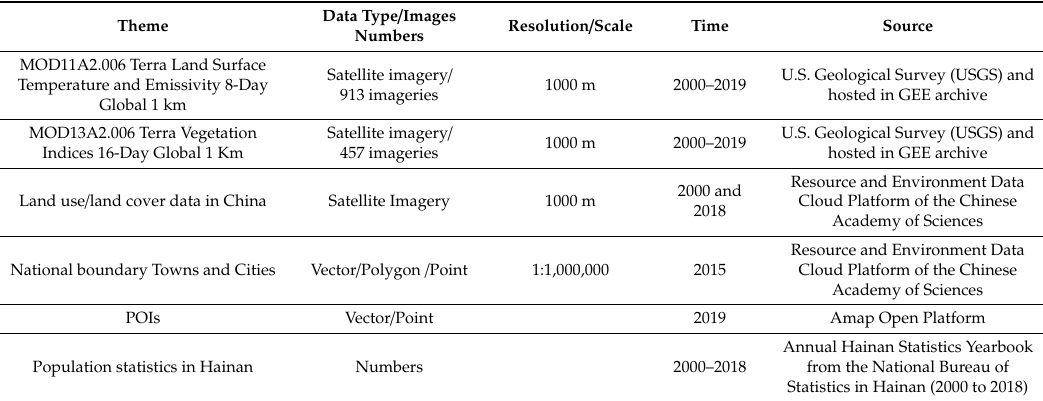
Table 1. Overview of the primary datasets.